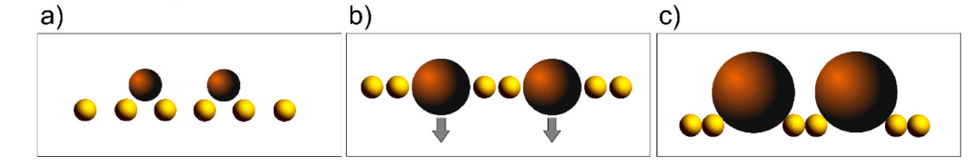
Figure 5. ( a – c ) Scheme of transport of solid particles through the emulsion structure at different particle sizes.